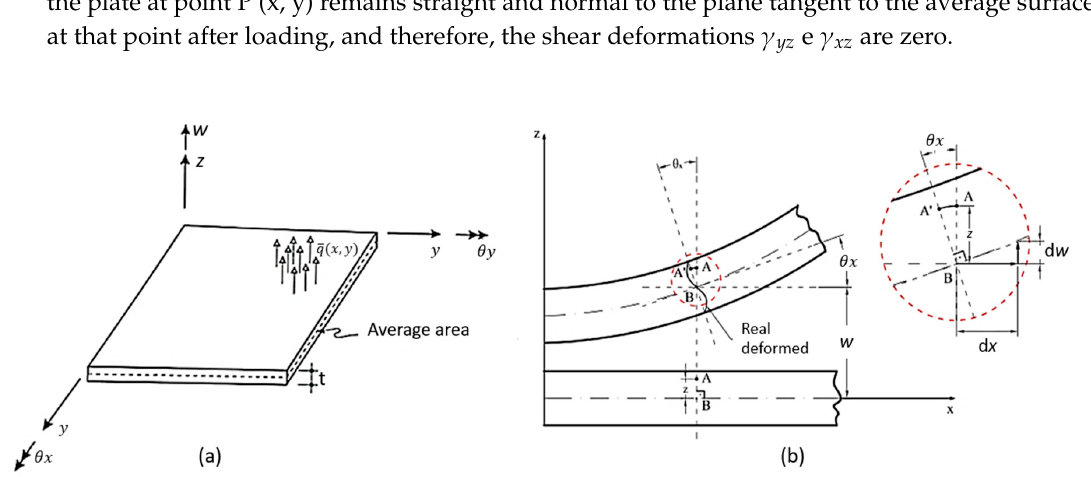
Figure 16. ( a ) Section of plate of thickness t, under transverse loading q per unit area, where w is a transverse displacement of a point of the mean surface, and θ x and θ y are the rotations normal to the same point according to the x and y axes. Reproduced with permission [75] . ( b ) Field of displacements according to Kirchhoff’s plate theory. Reproduced with permission [212] .